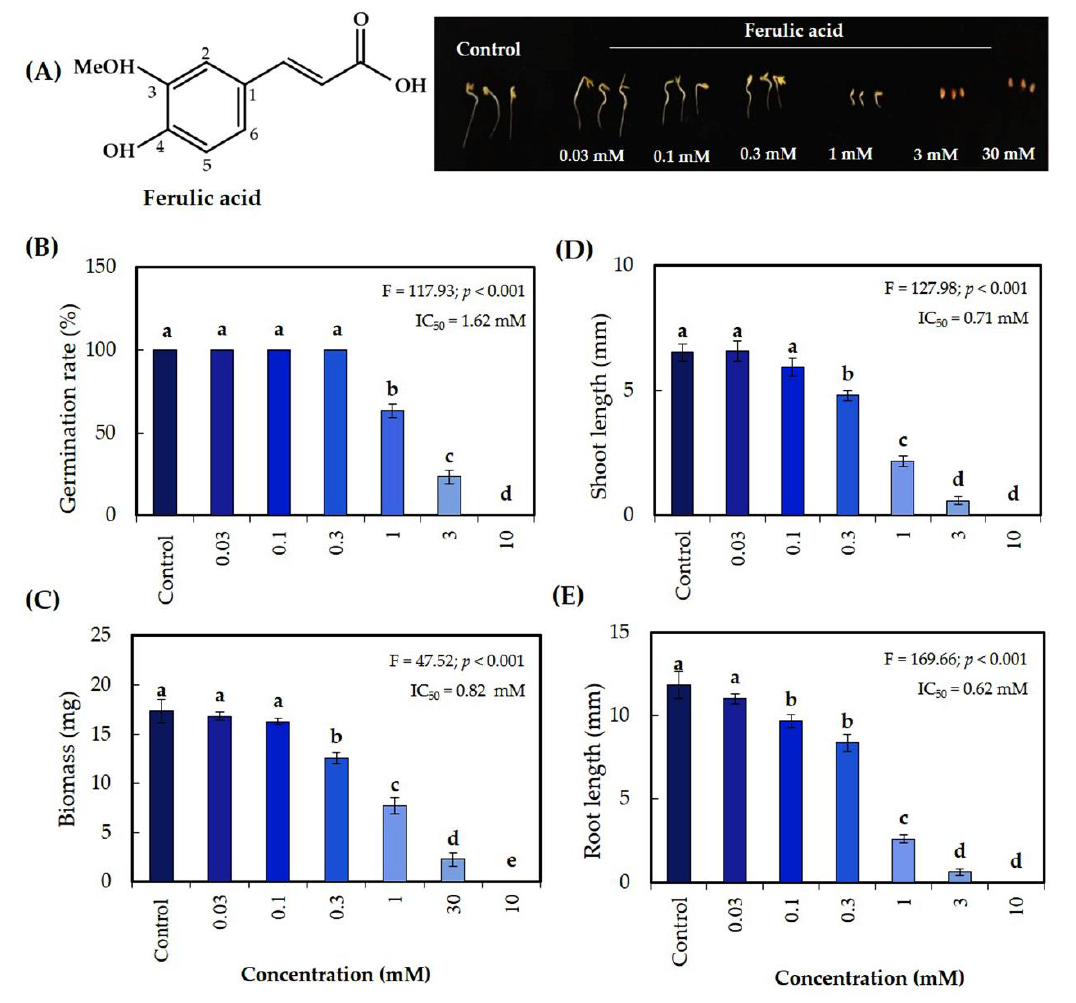
Figure 4. Growth inhibitory effects on Lepidium sativum exposed to ferulic acid isolated from the S. garrettiana leaf extracts. ( A ) L. sativum seedlings after 48 h of treatment, ( B ) seed germination, ( C ) dry biomass, ( D ) shoot length, and ( E ) root length. Values are the mean (±S.D.) of three replicates (n = 30); different letters on each bar indicate a statistically significant difference between treatments (Tukey’s HSD, at the 0.05 probability level).